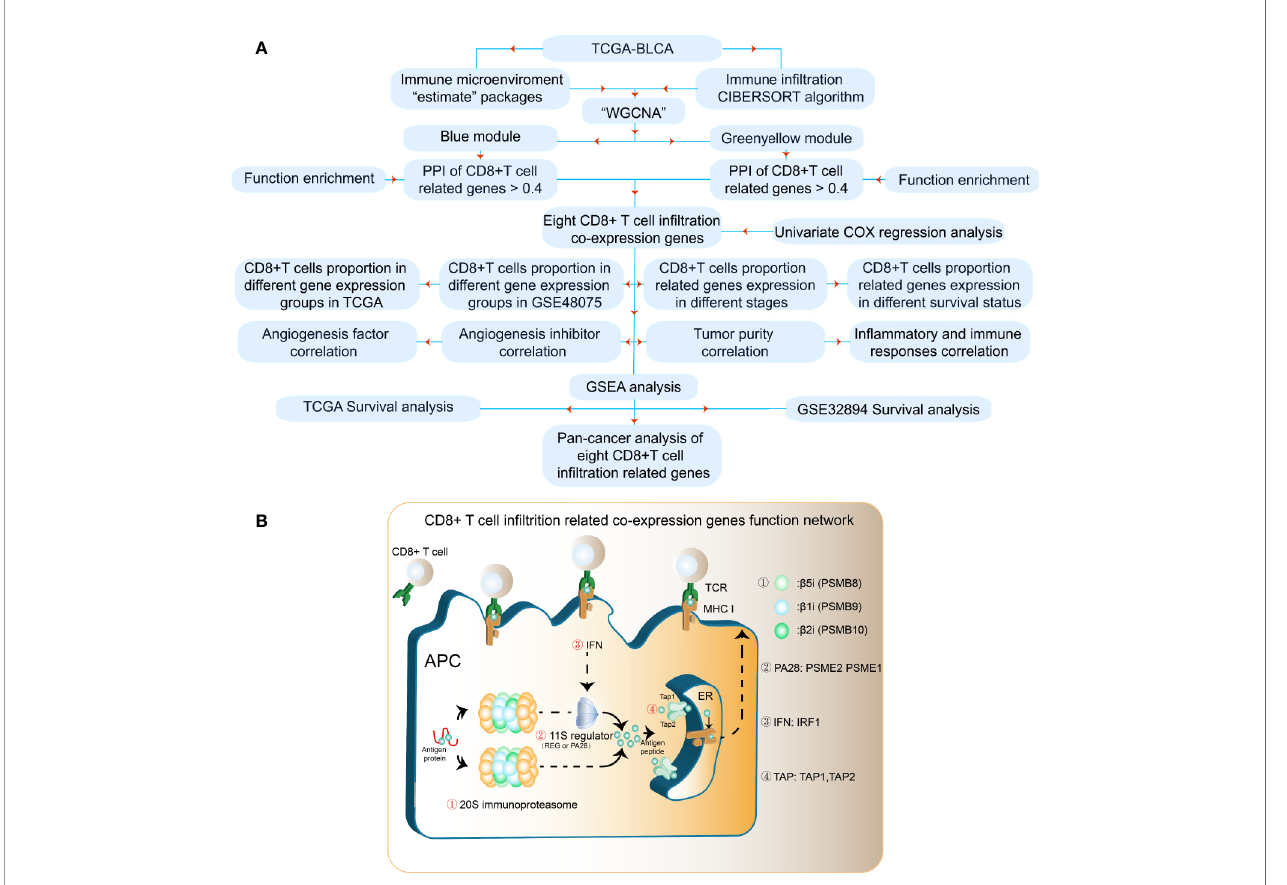
FIGURE 1 | Flowchart for identifying CD8 + T cell-promoting co-expressed genes. (A) TCGA-BLCA FPKM contained 414 cancer tissue samples and 19 normal tissues. GSE32894 contained 308 urothelial cancer samples and GSE48075 contained 142 primary bladder samples. WGCNA was used generate a co-expression network. GO analyses were applied to identify CD8 + T cell-related modules. Independent prognostic factors were selected using univariate Cox regression. (B) The antigen peptide presentation process is shown. Immunoproteasomes are composed of 20S subunits. PSMB8, PSMB9, and PSMB10 are the core of the 20S subunit. PA28 (PSEM2) is a regulator of immunoproteasomes that enhances the activity of the 20S subunit. Transporters associated with antigen processing (TAP1 and TAP2) reside in the endoplasmic reticulum (ER), and transport antigen peptides into the ER. The IFN-regulatory factor 1 protein (IRF1) is up-regulated by IFN g , and upregulates MHC class I antigen peptide presentation-related